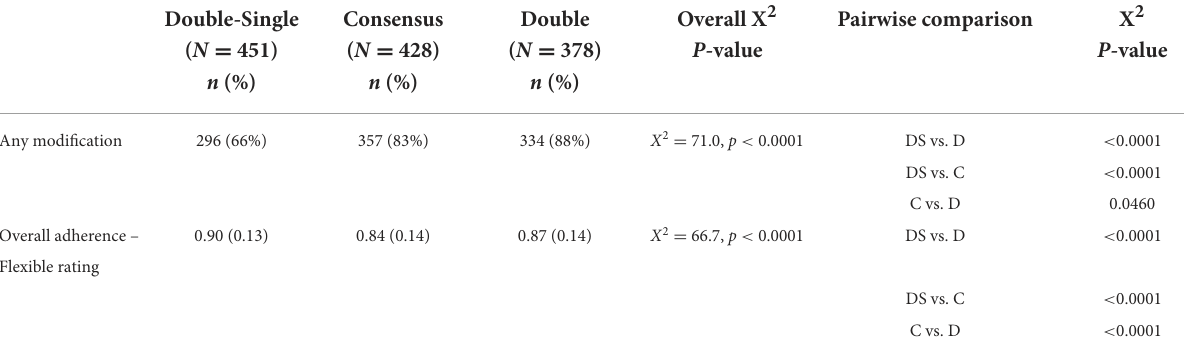
TABLE 5 Differences in modifications detected in different rating